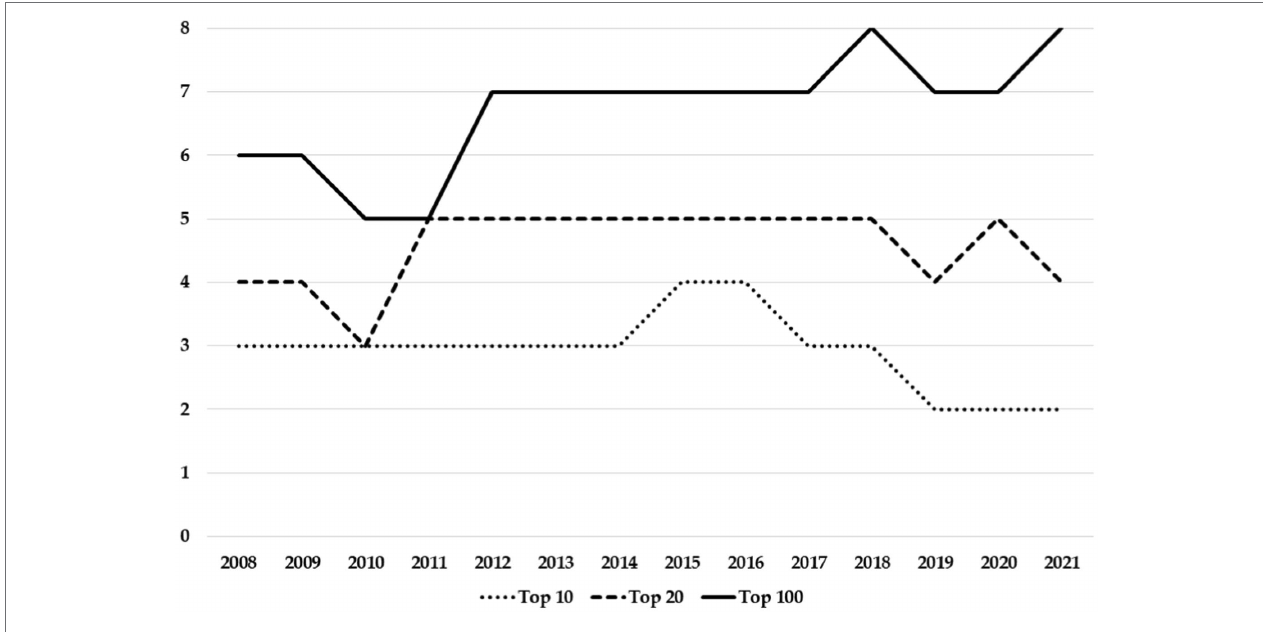
FIGURE 1 | Ibiza Clubs in the Top 100. Source: DJMag (2022) and own